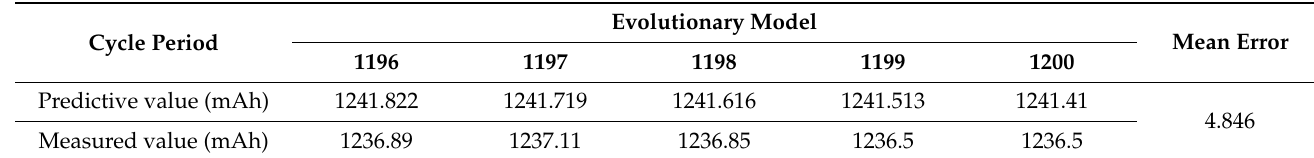
Table 5. The predictive and measured value of L1 battery capacity after model